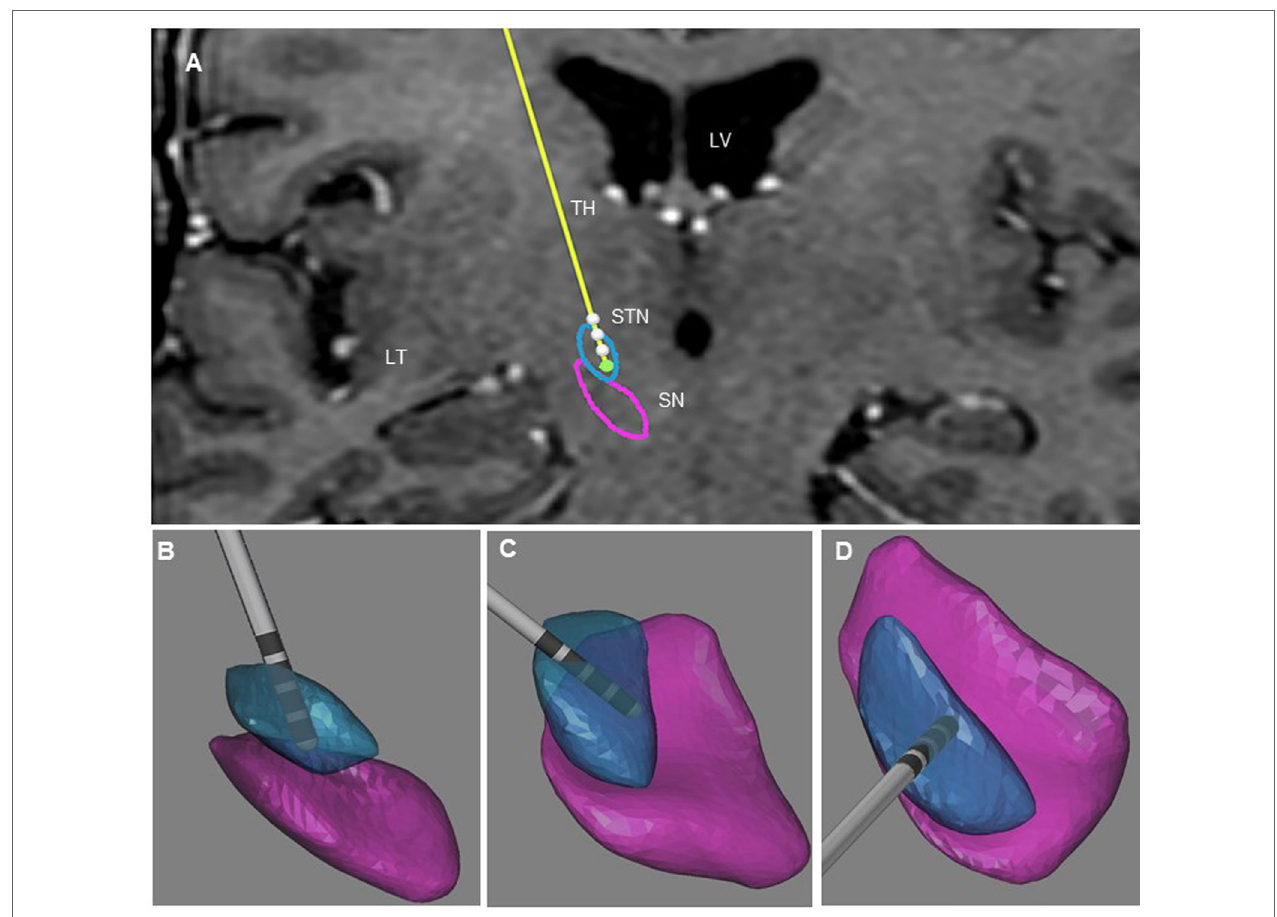
FIgURe 1 | Illustration of the three-dimensional anatomical location of the electrodes (patient 1). (a) Frontal view of the electrodes (in yellow) with the different contacts (white) and three-dimensional view of STN (in blue), and SNr (in purple). This representation is superimposed on the coronal T2 preoperative MRI of patient 1 to illustrate the location of the STN and SNr. Each electrode had four contacts with the length of 1.5 mm separated by 0.5 mm intervals and numbered from 0 to 3 in the right hemisphere. Contact 0 is the deepest contact (green). (B) Frontal view of the right STN and SNr. (C) Anterolateral view of the right STN and SNr. (D) Superior view of right STN and SNr. In (B–D) , the STN and SN were represented in transparency to show the location of the contacts and visualize the “laughter” contact 0 localized within the ventral and medial STN. LV, lateral ventricle; TH, thalamus; TL, temporal